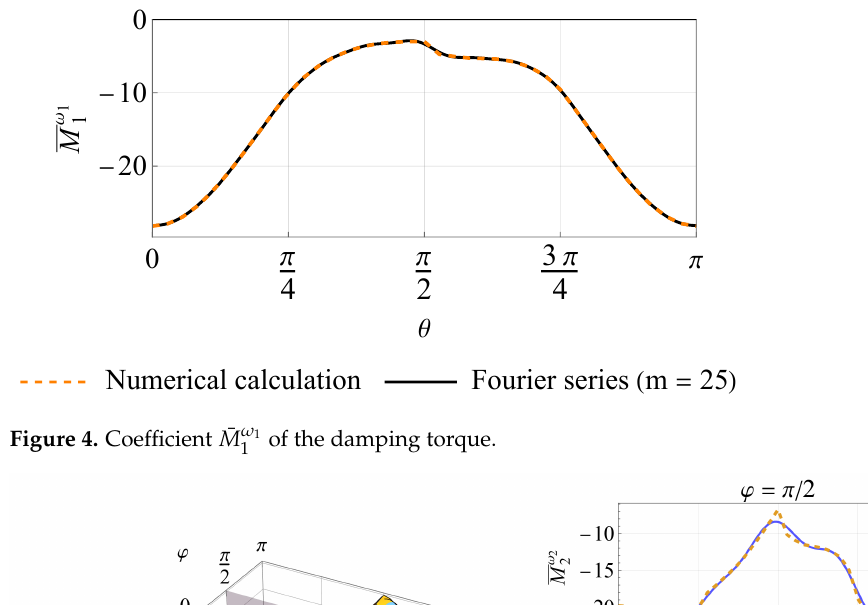
of the damping torque. 1